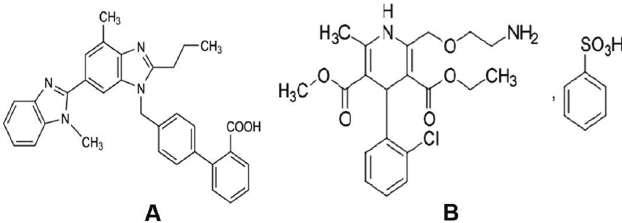
FIGURE 1- Chemical structure of telmisartan (A) and amlodipine besylate